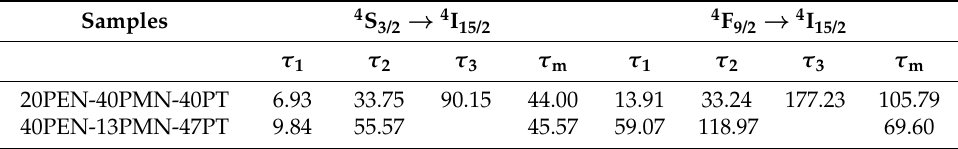
Table 1. Fitting results of fluorescent decay curve for the PEN-PMN-PT